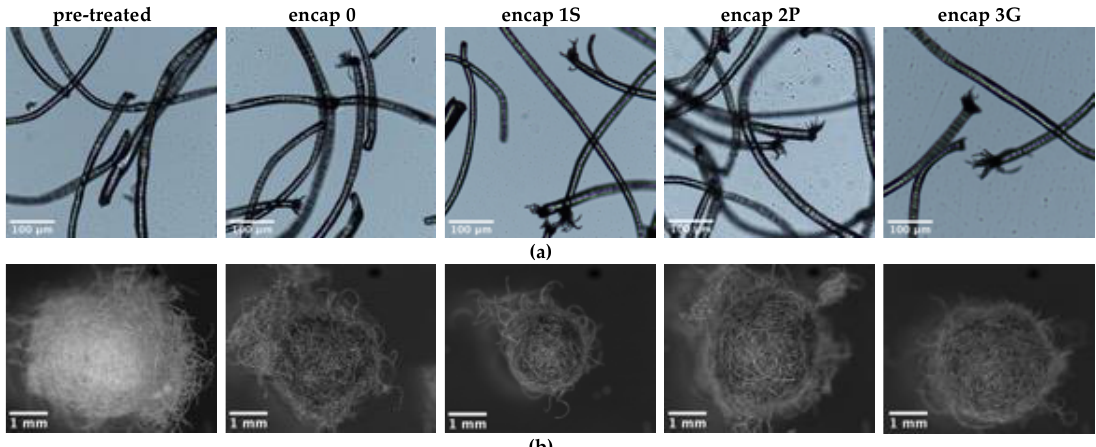
Figure 5. Effect of abrasion (50,000 cycles) on wool fibers. ( a ) Shed wool fibers. ( b ) Shed pills.